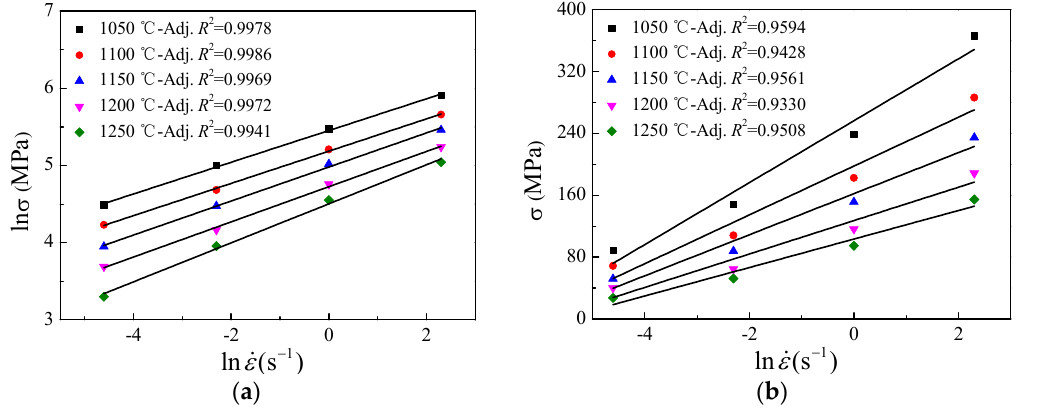
Figure 4. Relationship between ( a ) ln σ and ln . ε and ( b ) σ and ln . ε